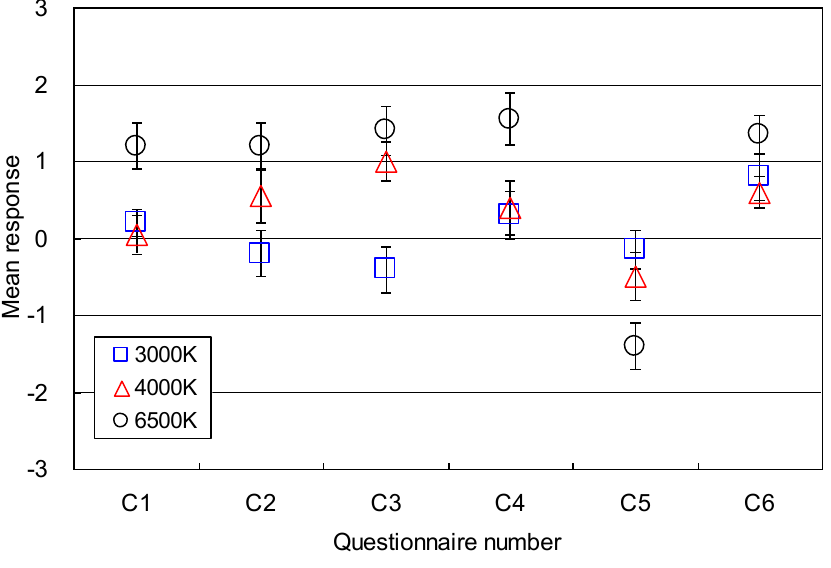
Figure 14. Visual comfort and annoyance (500 lx, Paper task).